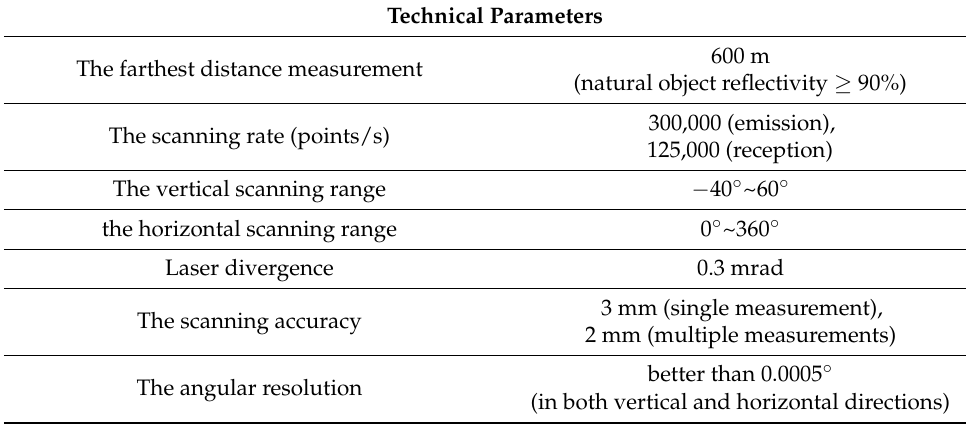
Table 1. The characteristics of the RIEGL VZ-400